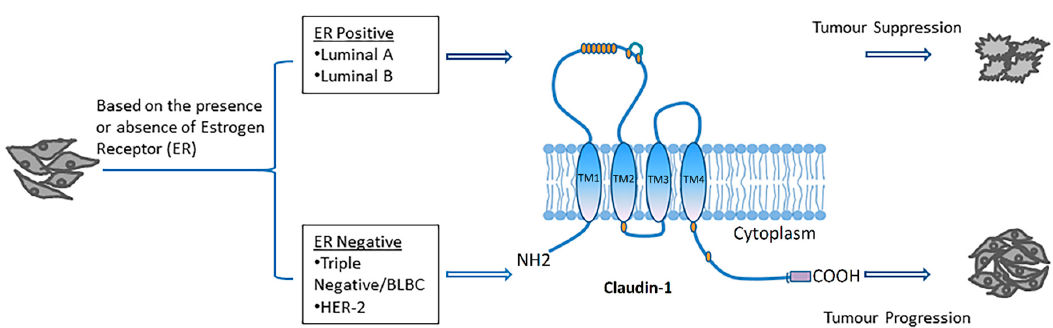
Figure 3. CLDN-1 expression in different subtypes of breast cancer as characterized by the presence or absence of estrogen receptor (ER). Luminal A, and Luminal B subtypes of human invasive breast cancer (ER-positive) exhibit low levels of CLDN-1, which suggests the suppressor role of CLDN-1 in these tumors. However, aggressive forms (ER-negative) exhibit overall high levels of CLDN-1 expression, which signifies CLDN-1 role as a tumor promoter.